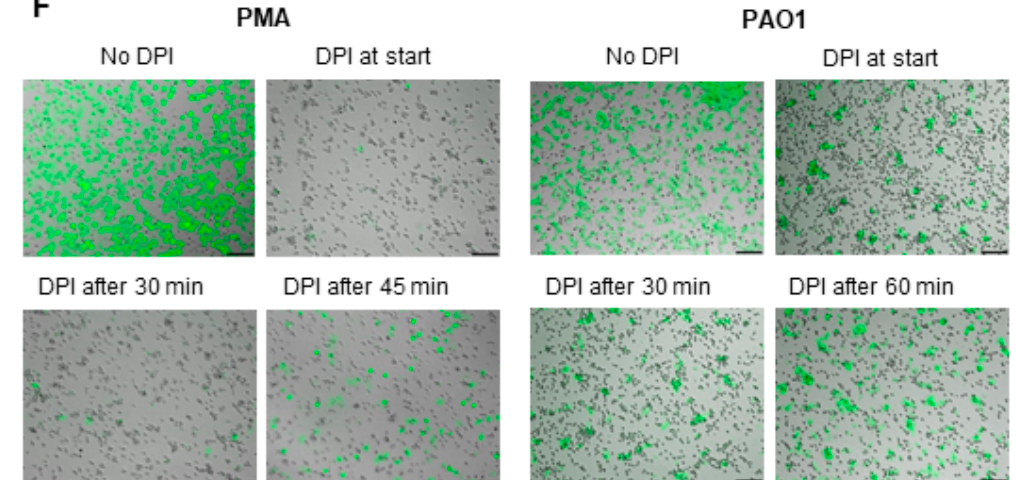
Figure 3. Reactive oxygen species produced by neutrophils early in the response to stimulation were not sufficient to induce NET formation. ( A ) Scheme of the experimental approach used to study the time when oxidants are important. Neutrophils were incubated with stimulant (time 0), and then DPI was added to inhibit further oxidant production at various time points after stimulation. After 4 h, the presence of NETs was assessed with Sytox green. ( B – E ) Neutrophils were stimulated for 4 h with PMA (20 nM), P. aeruginosa PAO1 (MOI 10), S. aureus (MOI 10) or C. albicans (MOI 2) in the presence or absence of DPI. Data are presented as the percentage of fluorescent DNA of cells with stimulant alone (No DPI). Data are means (SE) from 3–6 separate experiments with neutrophils from different donors. Stimulated cells treated with DPI were significantly different than stimulated without DPI ( p < 0.05 by one-way ANOVA followed by Dunnett’s